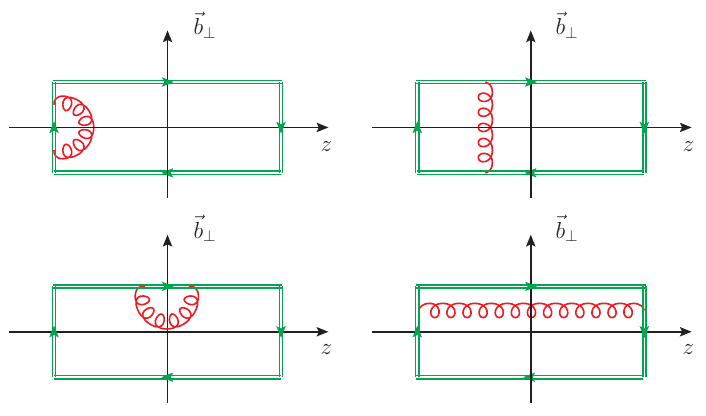
Figure 5 . One-loop Feynman diagrams for Z E (2 L,~b ⊥ , µ ) in the definition of quasi-TMDPDFs. Again, it differs from the result in the fundamental representation only by a color